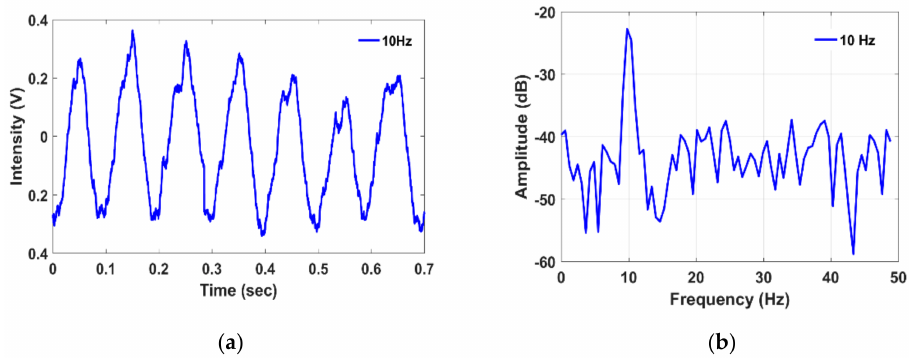
Figure 4. Measured ( a ) time domain and ( b ) frequency domain spectra (obtained using a fast Fourier transform [FFT]) under the 10 Hz sinusoidal vibration frequency.